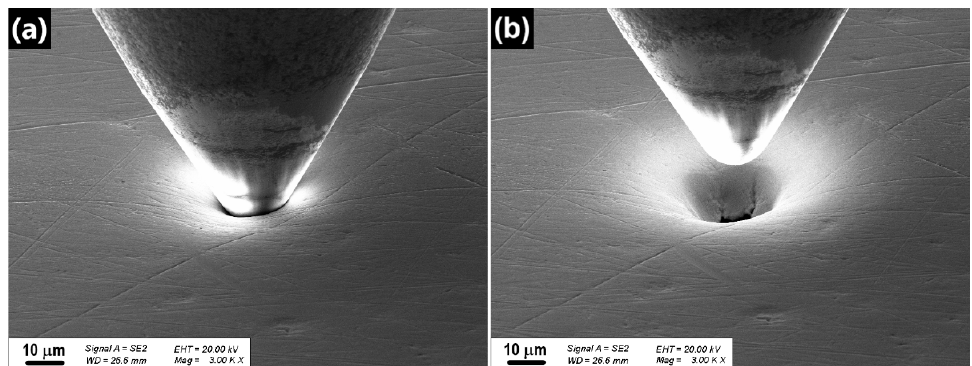
Figure 13. SEM micrographs of micro-punch tests performed in a 20 μ m-thick T91 DS membrane ( a ) during and ( b ) after the mechanical test.